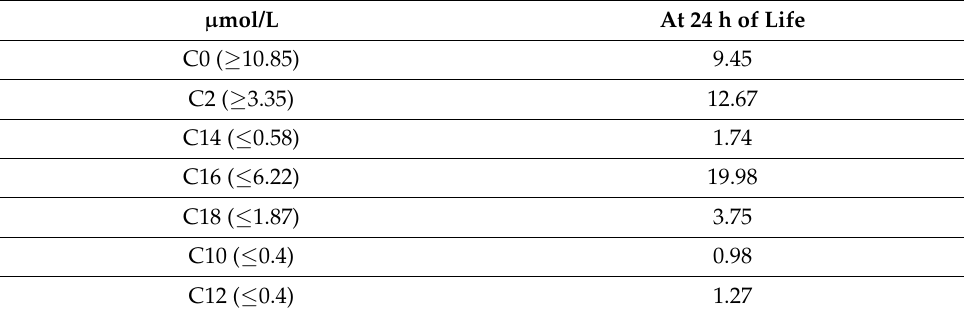
Table 1. Newborn Screening Result of Baby A.